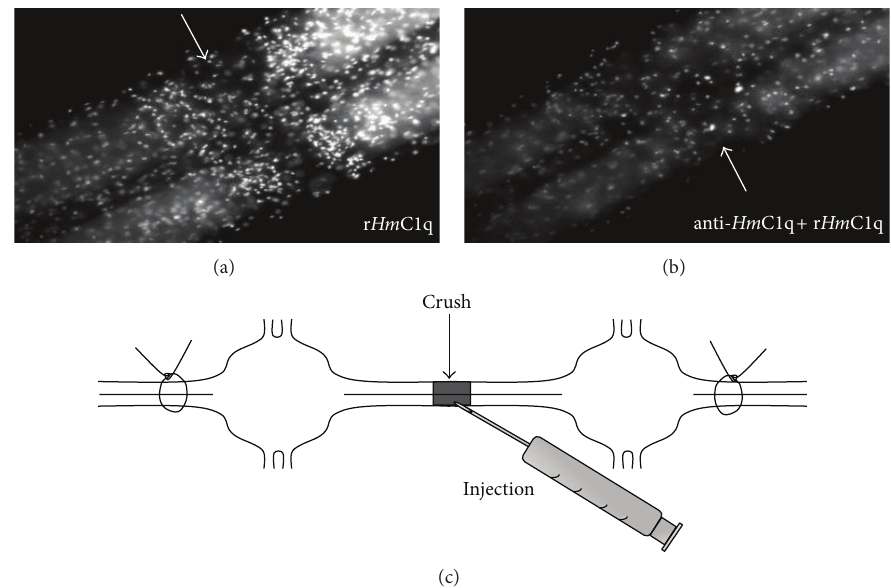
Figure 5: Chemotactic effect of recombinant Hm C1q on leech microglia in isolated and crushed segment of nerve cord maintained in tissue culture (see the diagram (c)). (a) Hoechst-dyed microglial cells strongly accumulated 4 hours after injection of r Hm C1q (arrows). (b) When tissues have been injected with polyclonal anti- Hm C1q antibody, the chemotactic activity of r Hm C1q has not been observed (arrows). To note, the corresponding preimmune serum did not exert any neutralizing effect (data not shown). (Reprinted, with permission, from [74]).